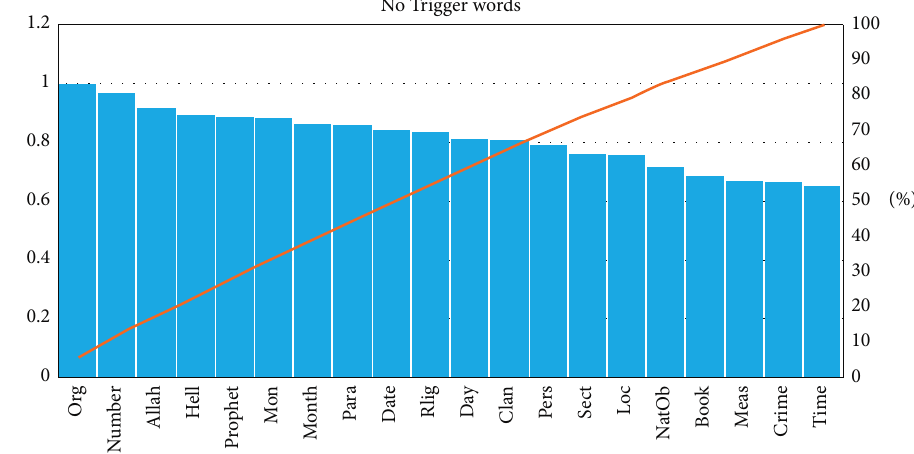
Figure 6: Results of not using trigger words. Table 12: Results of not using gazetteers.